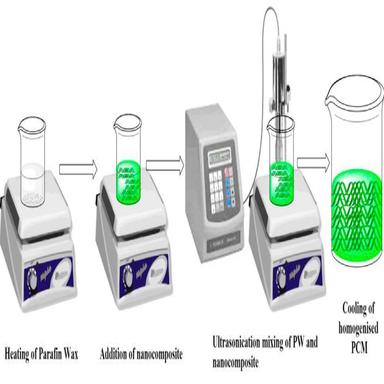
Schematic of sample preparation.